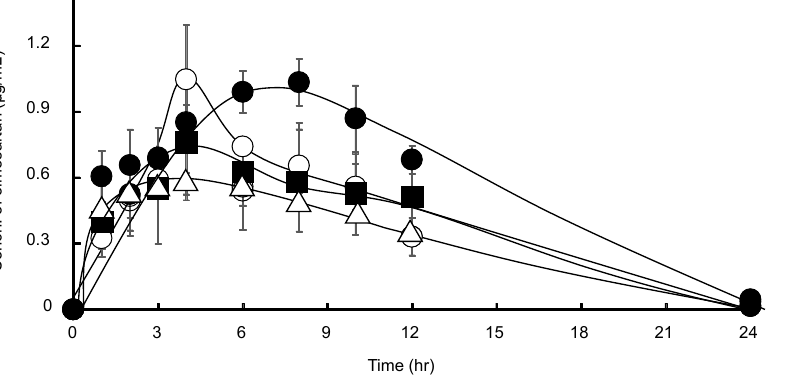
Figure 5. Mean plasma pharmacokinetic profiles of OLM ( △ ), OLM/SD-CS/lactose ( ■ ), OLM/SD-CS/HP- β -CD ( ○ ), OLM/SD-CS/SBE- β -CD ( ● ) suspensions in rats (at OLM dose of 8 mg/kg). (OLM = olmesartan tablets, SBE- β -CD = sulfobutyl ether- β -cyclodextrin, and SD-CS = spray-dried chitosan). Table 1. Pharmacokinetic parameters for olmesartan tablets (OLM) in rats following oral administration of the suspensions (8 mg/kg as the drug).